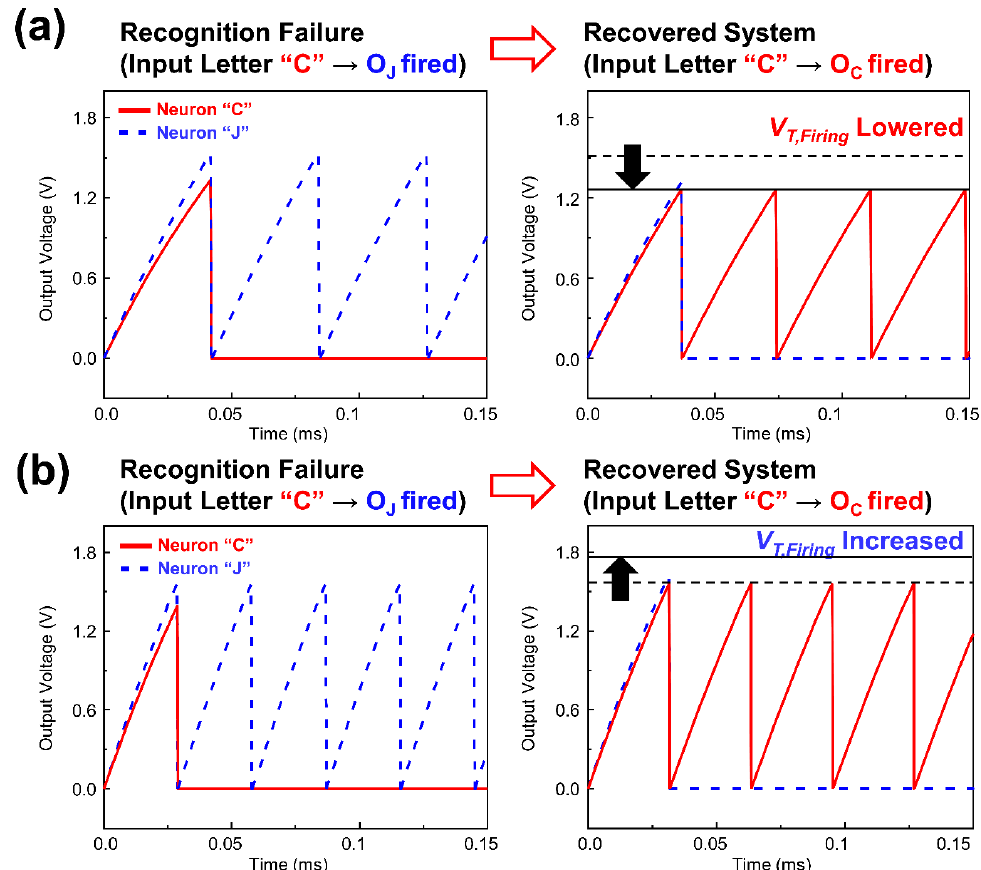
Figure 5. ( a ) Input images for letter recognition with 3 ×3 black-and white pixels and circuit configurations for the neural network system; ( b ) Results of the letter recognition.